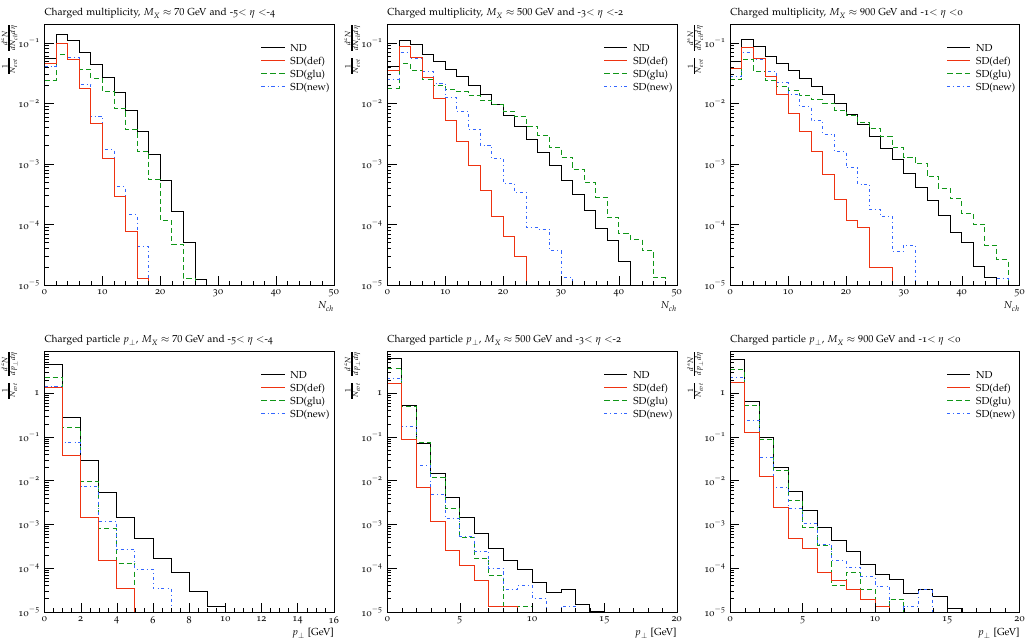
Figure 7 . Charged particle distributions in non-di(cid:11)ractive events (black lines marked ND) com- pared to di(cid:11)erent options (SD(def): red lines, SD(glu): green dashed lines, and SD(new): blue dash-dotted lines) for single di(cid:11)ractive excitation events in di(cid:11)erent rapidity slices and di(cid:11)erent excitation masses, M X . The top panel shows the multiplicity of charged particles, and the bottom panel their transverse momentum